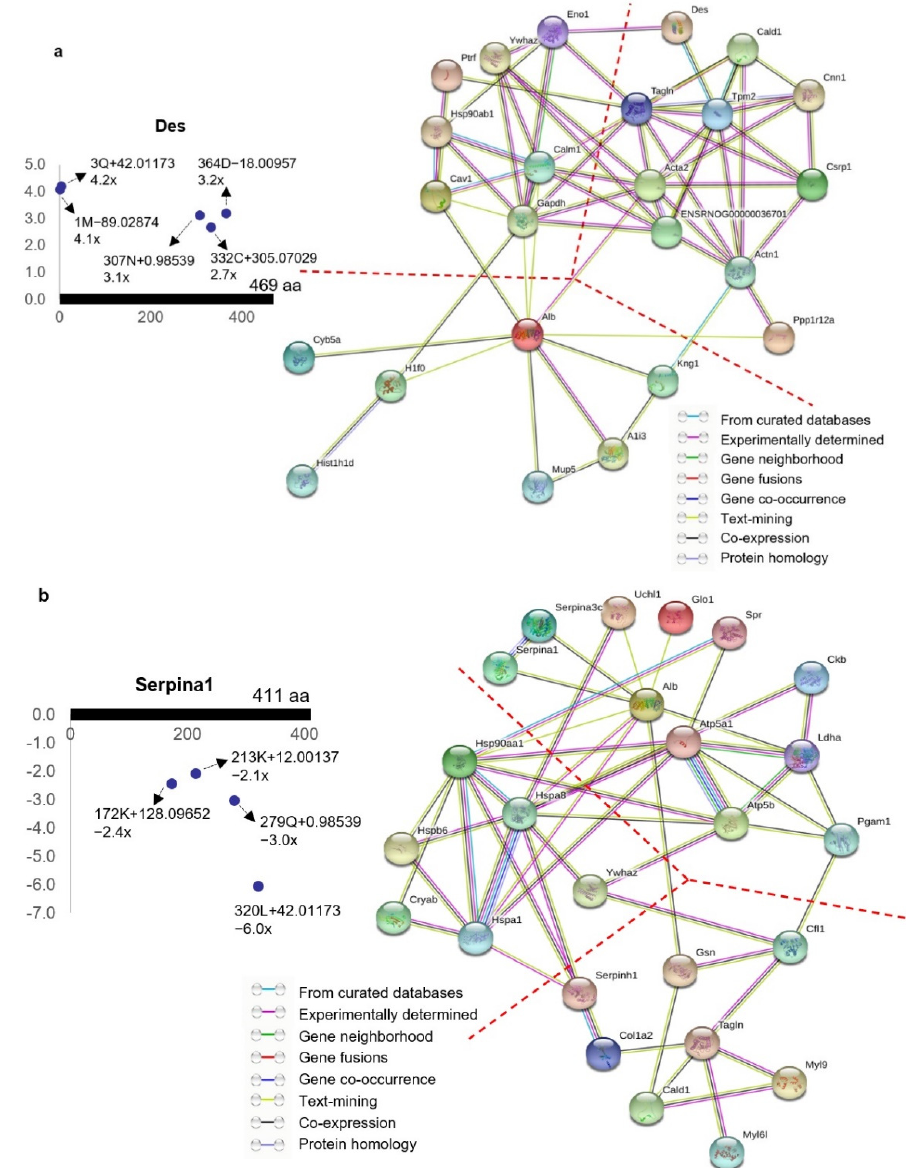
Figure 13. Protein–protein interaction networks of ischemia-associated ncAA-containing proteins. Network nodes and edges represent proteins and protein–protein associations, respectively. The color of the network edge indicates the type of interaction evidence. ( a ) Protein–protein interaction networks formed between 30 upregulated ischemia-associated ncAA-containing proteins (R 2 > 0.5, ratio > 2, p < 0.05). Each protein had upregulated ischemia-associated ncAAs. Des is shown as an example. The annotation information of each dot, which represents ncAA, is as follows: modified (protein) position, modified amino acid residue, delta mass, and ratio of modification. The horizontal axis represents the amino acid position of Des; the vertical axis represents the ratio of modification. The interaction networks were broadly divided into three clusters: cell signaling-related proteins ( left ), cytoskeleton-associated proteins ( right ), and binding/transport-related proteins ( bottom ) (24 connected proteins are shown, and the clusters are divided with dotted lines). ( b ) Protein–protein interaction networks formed between 33 downregulated ischemia-associated ncAA-containing proteins (R 2 > 0.5, ratio < − 2, p < 0.05). Each protein had downregulated ischemia-associated ncAAs. Serpina1 is shown as an example. The annotation information of each dot, which represents ncAA, is as follows: modified (protein) position, modified amino acid residue, delta mass, and ratio of modification. The horizontal axis represents the amino acid position of Serpina1; the vertical axis represents the ratio of modification. The interaction networks were broadly divided into three clusters: molecular chaperones ( left ), metabolic enzymes ( right ), and cytoskeleton-associated proteins ( bottom ) (25 connected proteins are shown, and the clusters are divided with dotted lines). This figure is taken from our previous publication [68].